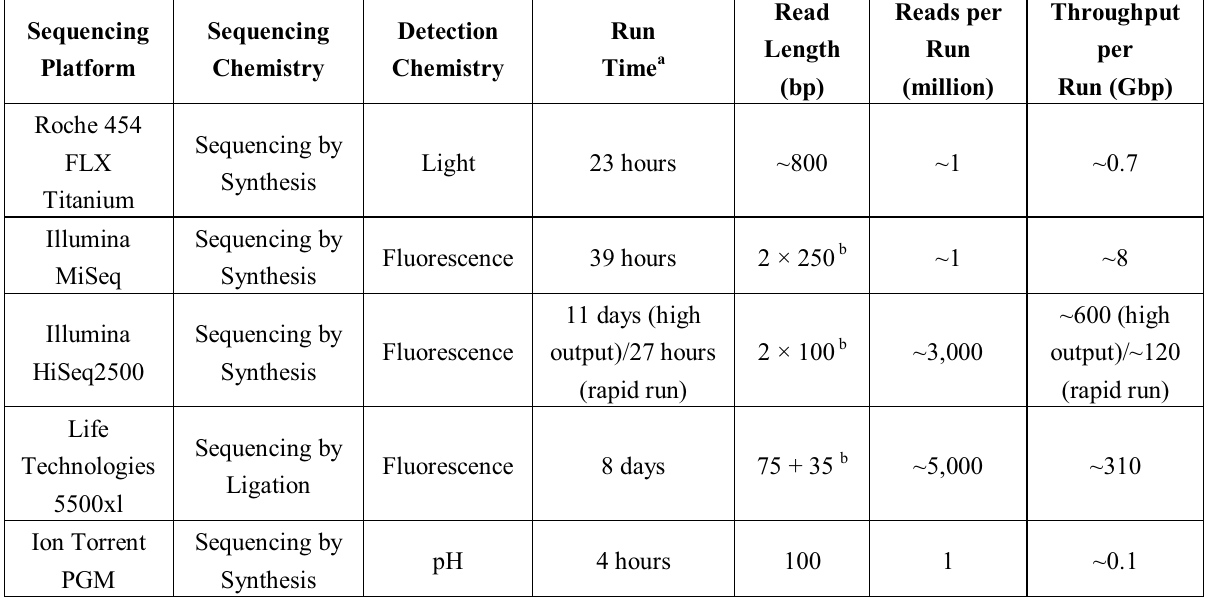
Table 1. Comparison of representative next-generation sequencing